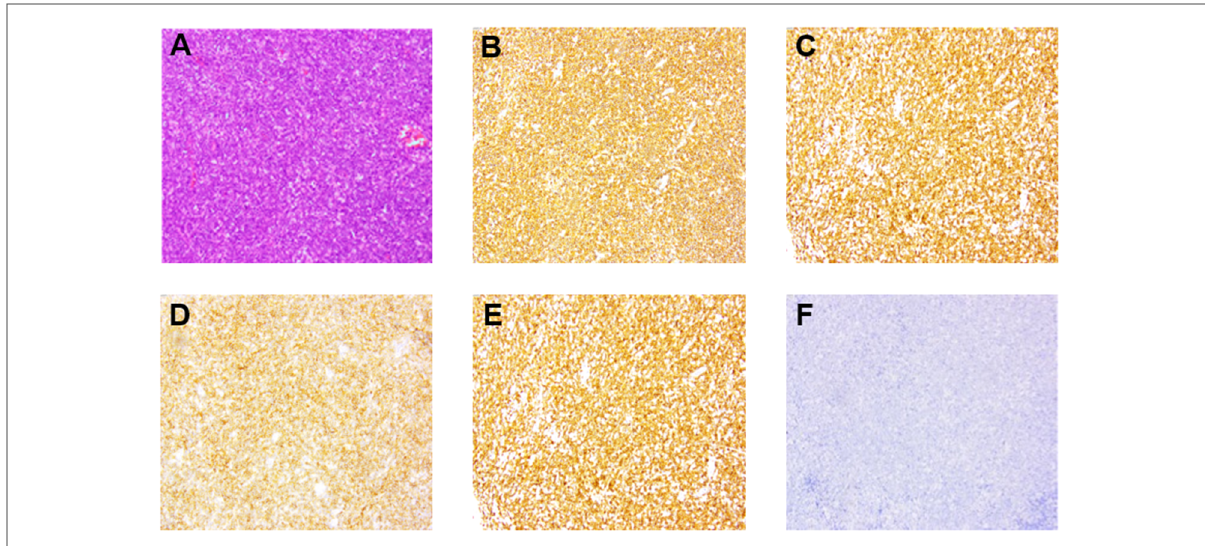
FIGURE 3 Pathological changes of specimen from the enlarged mediastinal lymph nodes. Medium-large heterotypic lymphoid cells showed diffuse and fl aky hyperplasia. ( A ) (Hematoxylin and eosin stain, ⊆ 100) the cells were round/oval; the cytoplasm was red stained; the nuclear chromatin was rough, and the mitotic fi gures were abundant. ( B – E ) (Immunohistochemical stain, ⊆ 100) CD20 and CD79a high expression suggested B-cell origin. CD10 and BCL6 positive expression suggested the germinal center B-cell (GCB) type. ( F ) Fluorescence in situ hybridization (FISH) suggested EBER negative expression.